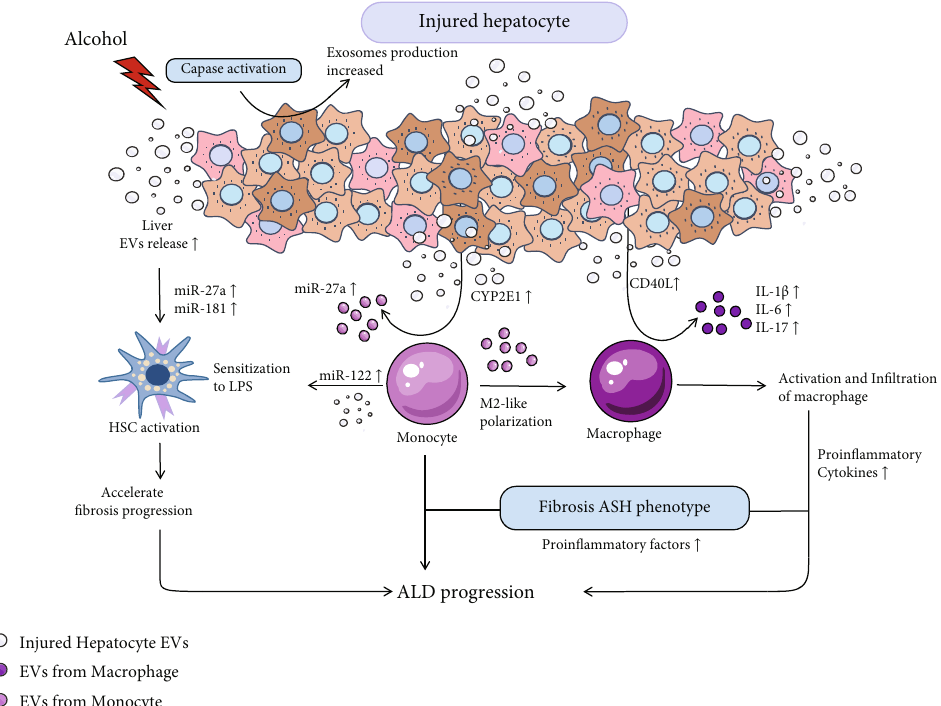
Figure 2: Exosomes in progression of alcoholic liver disease (ALD). Circulating exosomes play a signi fi cant role in lipid and cholesterol metabolism in alcoholic liver disease. During the progression of alcoholic liver disease, many pathways lead to the increased of exosome release. These exosomes activate hepatic stellate cells and promote fi brotic deposition. They are absorbed by immune cells such as monocytes and macrophages. Ultimately, a large number of proin fl ammatory factors are released, promoting the transformation of AFL into